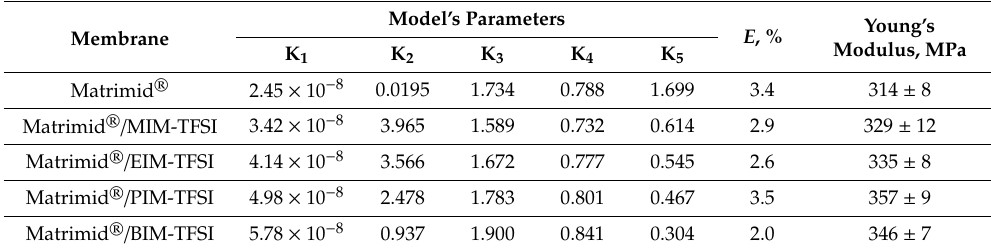
Table 5. The D’Arcy and Watt model parameters (Equation (9)), the mean relative deviation modulus E (Equation (8)) and the Young’s modulus values for the Matrimid ® / PIL composite membranes.